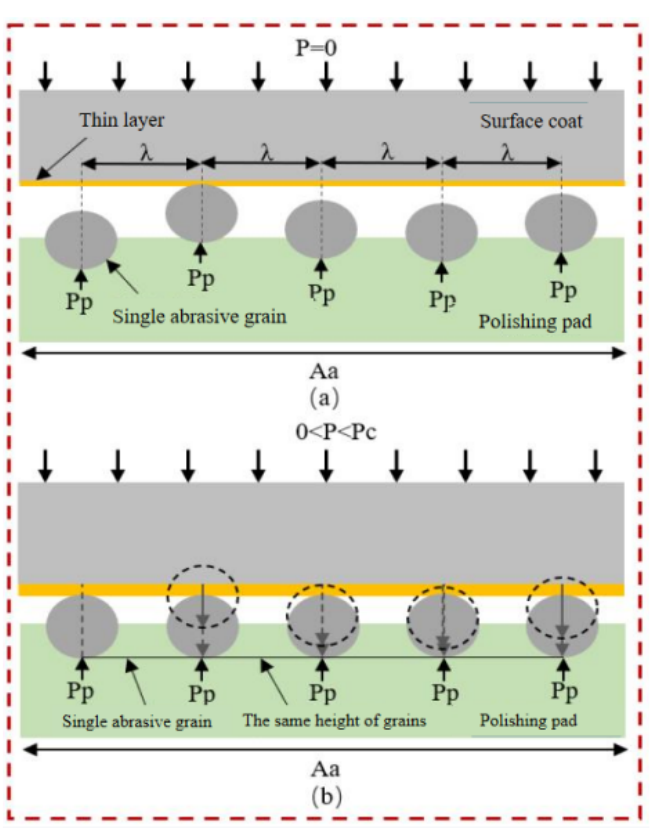
Figure 2. Schematic diagram of the abrasive particle movement of the self-regressive fixed abrasive. ( a ) Schematic diagram of no pressure applied, and ( b ) schematic diagram of applied pressure and of pressure less than critical pressure.